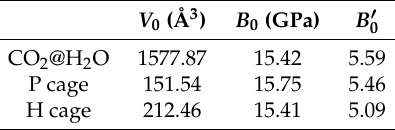
for the CO 2 hydrate, and its P and H cages. 0